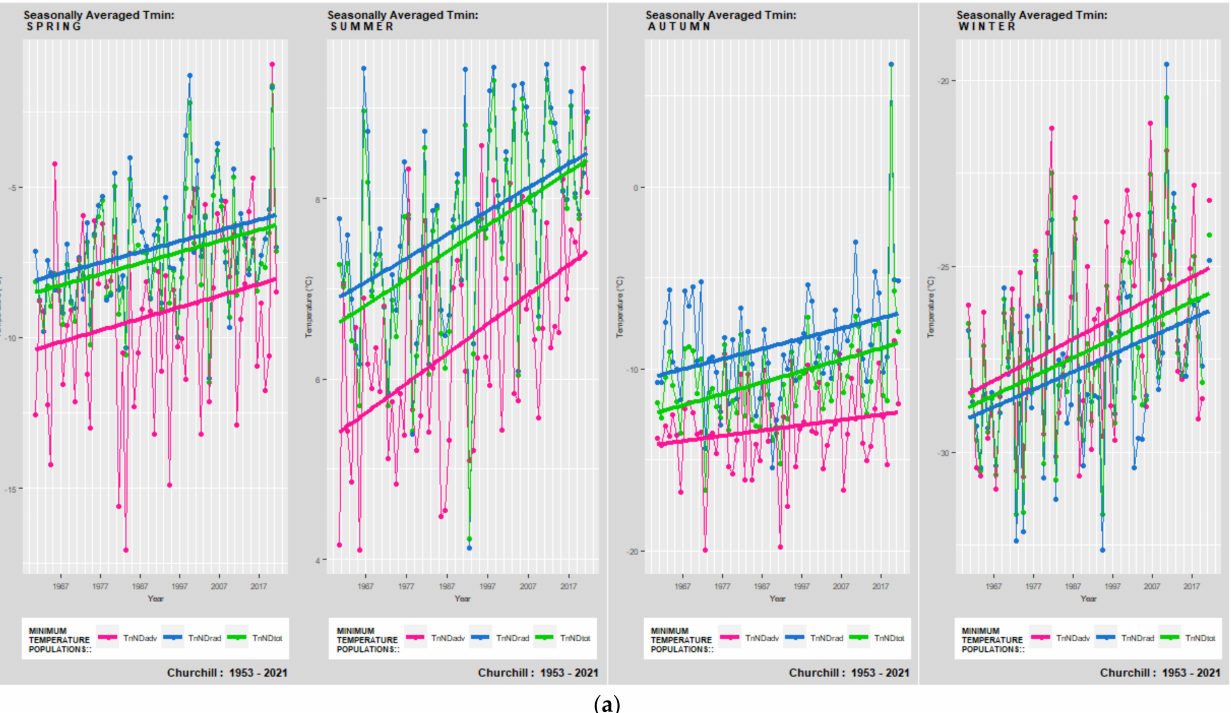
Figure 9. Great Lakes/St. Lawrence Lowland (GRL); Toronto (ON). Seasonally averaged daily temper- ature minima ( a ) and maxima ( b ), listed in order of Spring, Summer, Autumn, and Winter. ( a )—Total Temperature Minimum ( TT n ) (green), Radiative Temperature Minimum ( RT n ) (blue), and Advective Temperature Minimum ( TT n ) (pink); ( b )—Total Temperature Maximum ( TT x ) (brown), Radiative Temperature Maximum ( RT x ) (orange), and Advective Temperature Maximum ( TT x ) (purple).